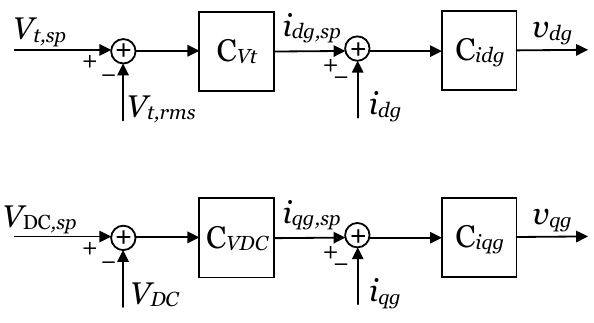
Figure 6. Schematic diagram of the grid-side converter (GSC)